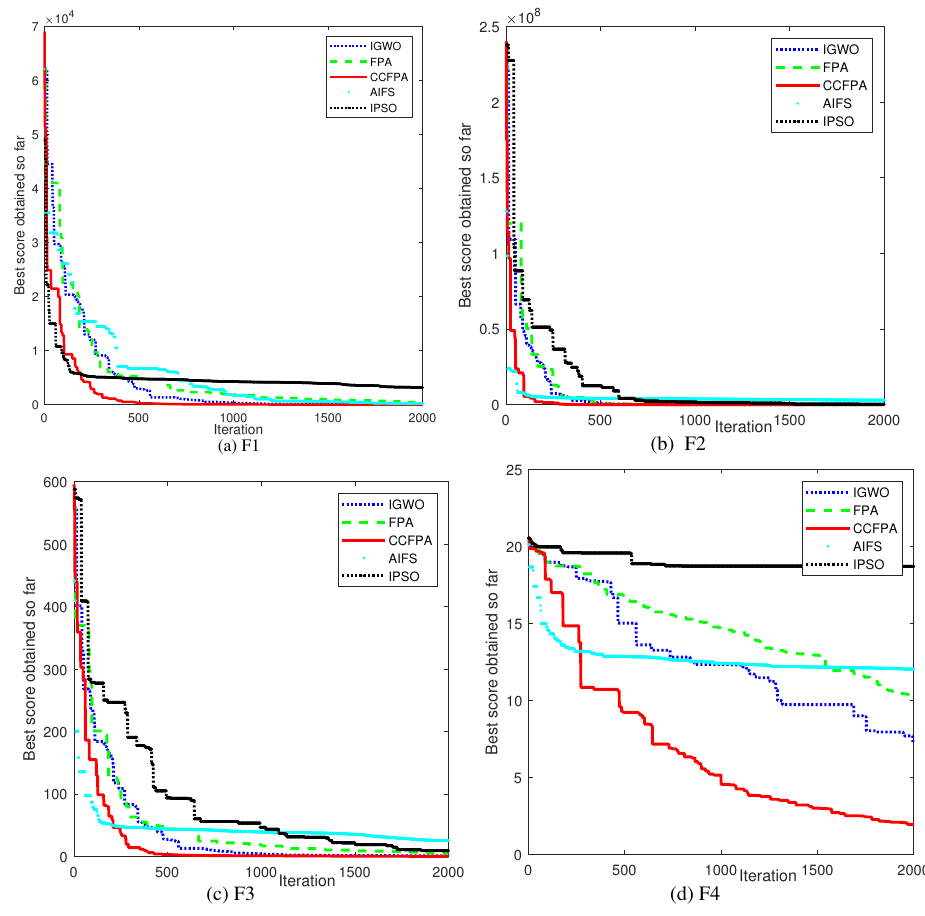
Figure 4. ( a – d ) are the convergence curves of the F 1 , F 2 , F 3 , F 4 functions,